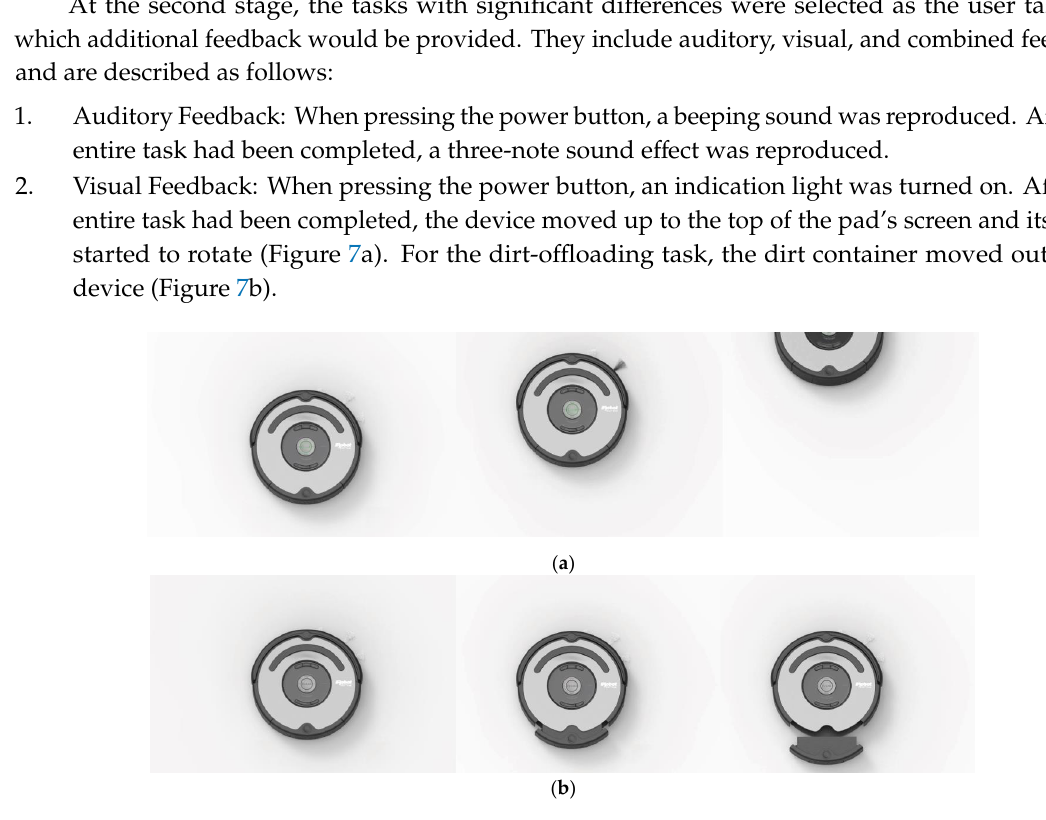
Figure 7. Visual virtual prototype responses with various feedback to ( a ) cleaning and ( b ) dirt- offloading.